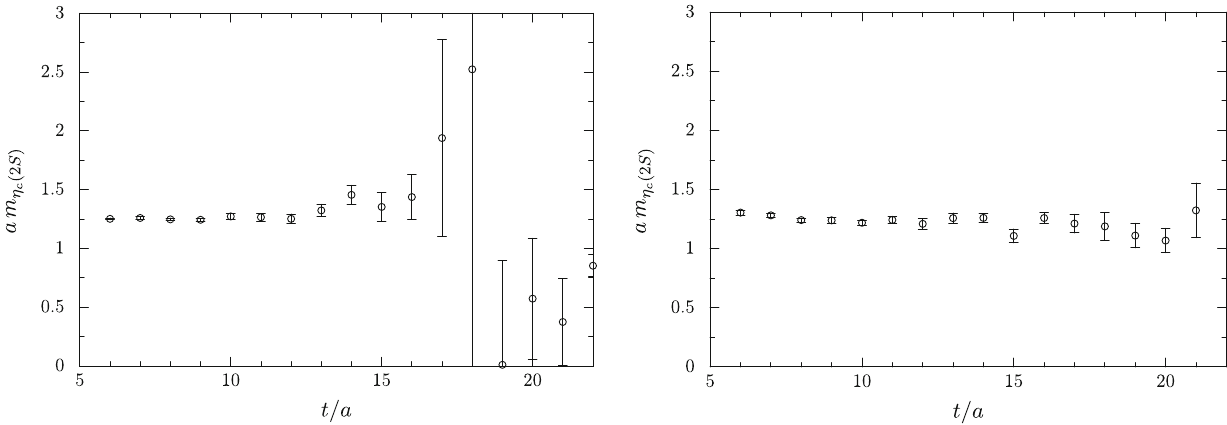
Fig. 2 Effective mass of the η c ( 2 S ) state extracted from the correlator ˜ C 2 along the ground state generalized eigenvector v P (right plot) to project C A L 0 P